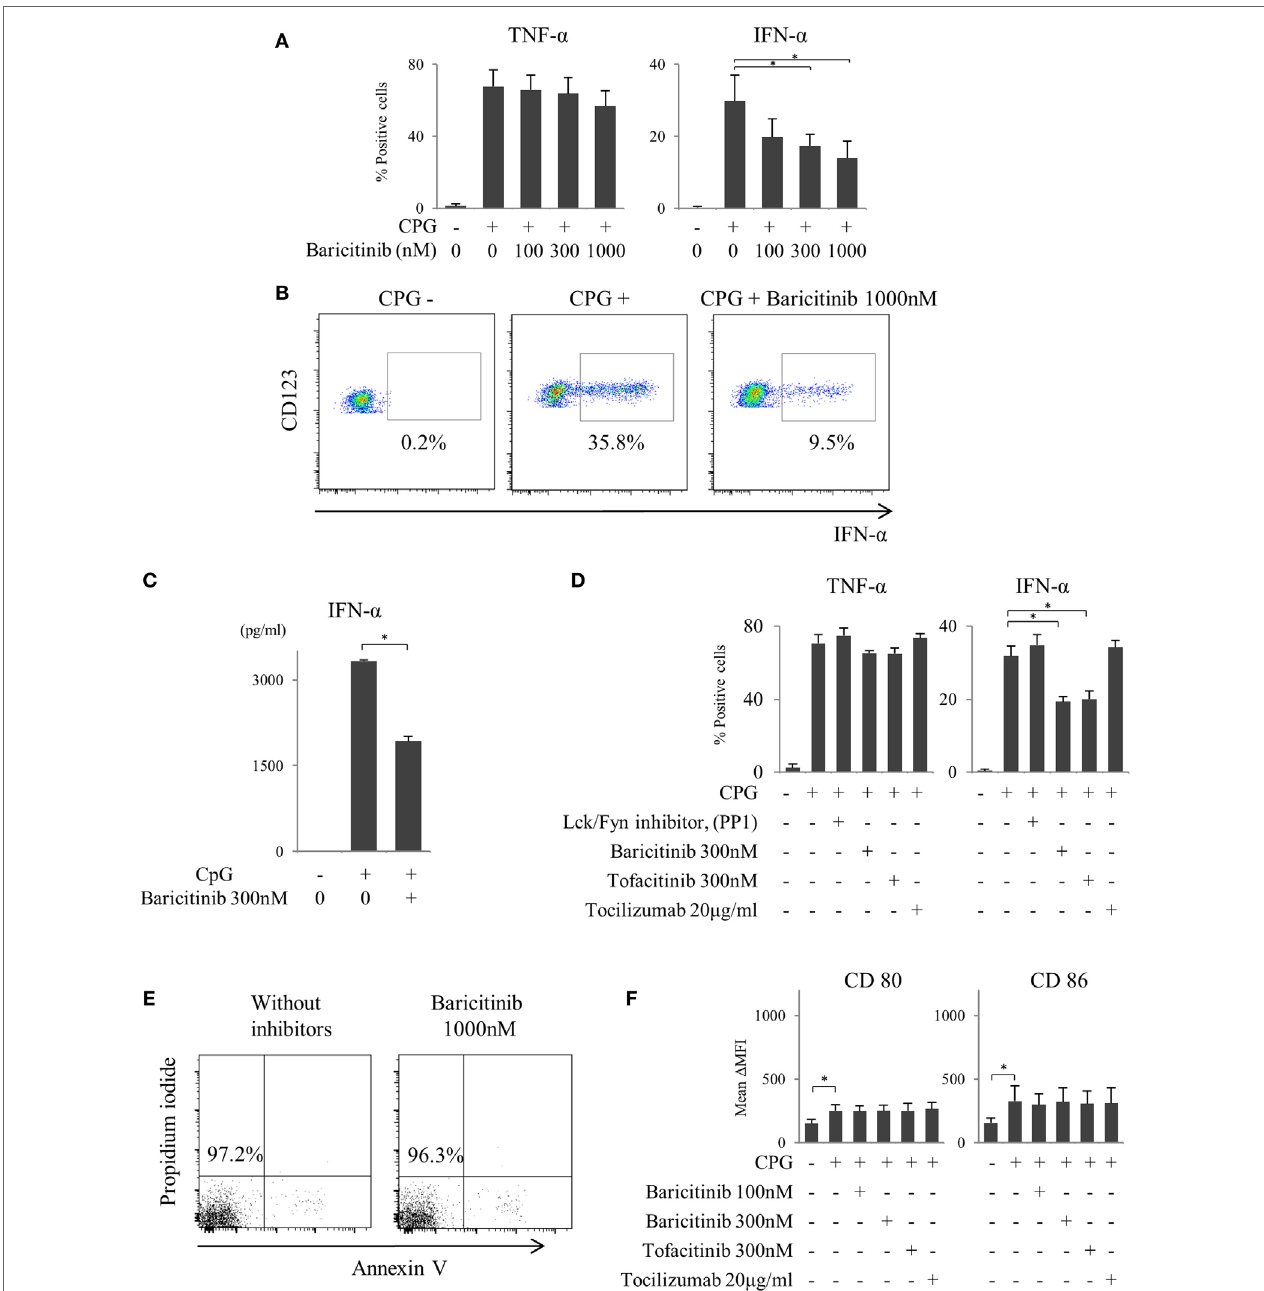
FigUre 3 | Baricitinib suppresses type-I interferon (IFN) production from plasmacytoid dendritic cells (pDCs). Peripheral blood mononuclear cells were stimulated with toll-like receptor (TLR) 9 agonist with or without baricitinib and other inhibitors. TLR9-mediated cytokine production by pDCs (Lin − HLA-DR + CD11c − CD123 + cells) was measured by intracellular staining or ELISA. (a) Percentage of TNF- α - and IFN- α -producing pDCs. (B) Representative flow cytometry plots showing IFN- α production by pDCs. (c) IFN- α concentration in the supernatants. (D) Percentage of TNF- α - and IFN- α -producing pDCs in the presence of baricitinib and other inhibitors. (e) Representative histogram data of annexin V/propidium iodide staining from three independent experiments. (F) Expression of CD80 and CD86 on pDCs. Data are mean ± SD of three different donors per group. * p < 0.05 (by Student’s t